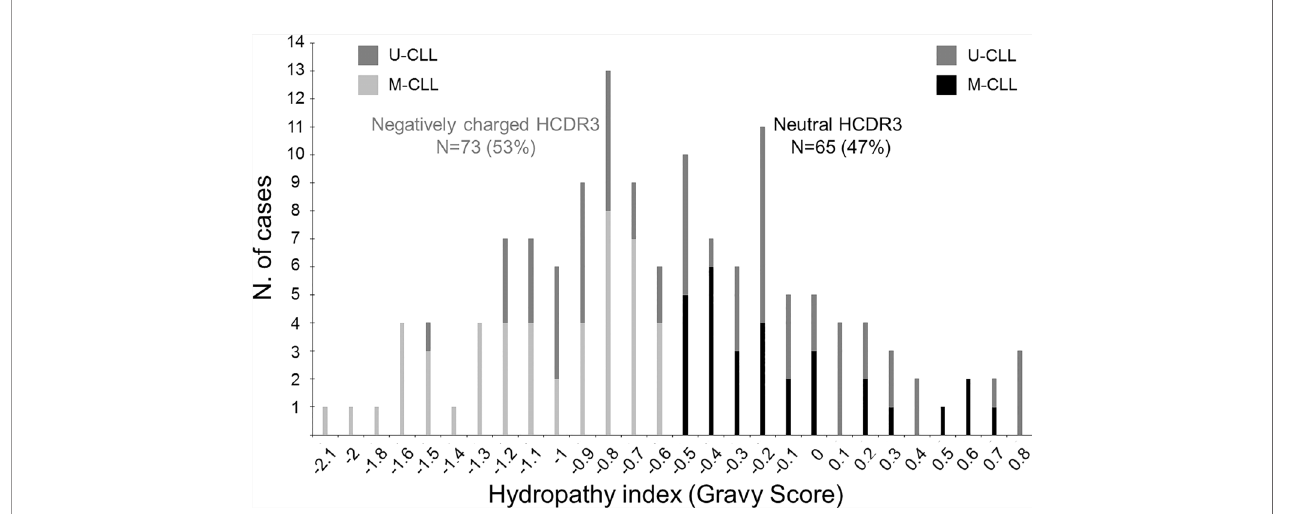
FIGURE 1 | Distribution of CLL patients according to the hydropathy index — Gravy score (GS) — of the HCDR3 aa sequence of their BCR. Bars represent the number of CLL patients (N = 138) with different HCDR3 GS. Black bars correspond to M-CLL patients with a GS ≥ -0.5 (neutral HCDR3; N = 65), light gray bars correspond to M-CLL patients with GS < -0.5 (negatively charged HCDR3; N = 73), and dark gray bars represent cases with a ≥ 98% identity to the V(H) germline (U-CLL) independently of their